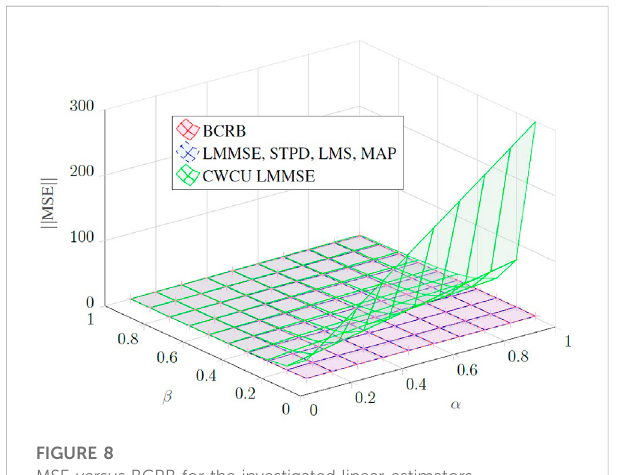
FIGURE 9 Monte Carlo simulation of an uncoded 16-QAM employing a 4 × 4 SM-MIMO-OFDM in time-varying and frequency selective